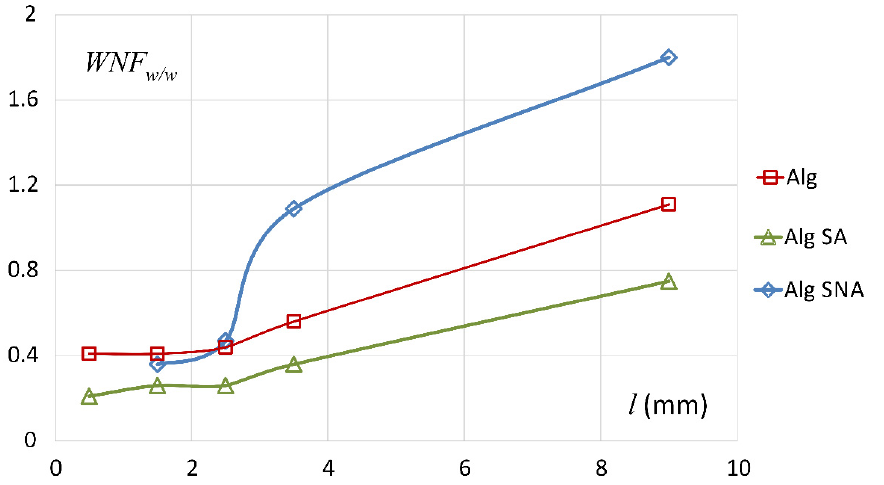
Figure 7. The fraction of non-freezing water weight per dry matrix weight expressed as WNF w/w (detailed description in the text) for subsequent slices of ALG/SA, ALG/SNA and ALG matrices after hydration in distilled water for 4 h—continuous lines serve as visual guide only.